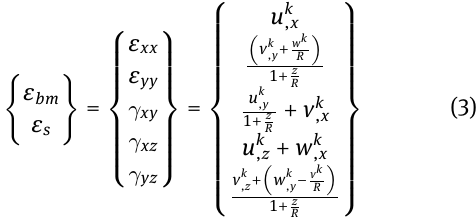
The buckling analysis of sandwich cylindrical pan- els is formulated based on the First-order Shear Deforma- tion Theory (FSDT) of sandwich/laminated shells. There- fore, transverse shear deformation, of which the effects are not negligible in the case of thick sandwich structures, is considered in the analysis. Since analytical solutions are restricted to specific boundary conditions, finite element method has been chosen to solve the governing differen- tial equations of the global buckling problem, considering stretching-bending coupling